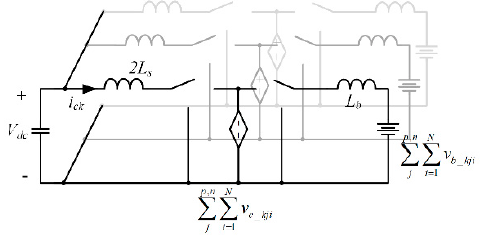
Figure 5. DC side equivalent circuit of the MMC-BESS.